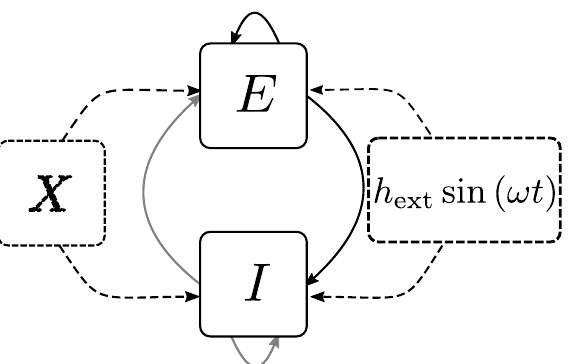
Fig 2. Recurrentbalanced network driven by oscillatory input. Recurrentlyconnectedexcitatory ( E ) and inhibitory( I ) populations (Erd ő s-Re´nyi random network with connectionprobability p ) receivinginput from an external( X ) excitatory population. Additionally,all neuronsin the microcircuitreceivea sinusoidalsignalof amplitude h ext and frequency ω , representing the oscillatory activity receivedfrom externalbrain